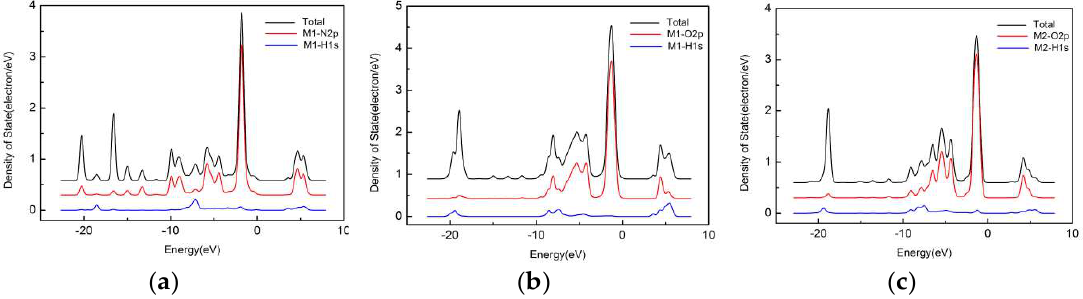
Figure 7. The PDOS curves of M1, M2 structures; ( a) : O – H PDOS curves of M1; ( b ): N – H PDOS curves of M1; and c : O – H PDOS curves of M2.